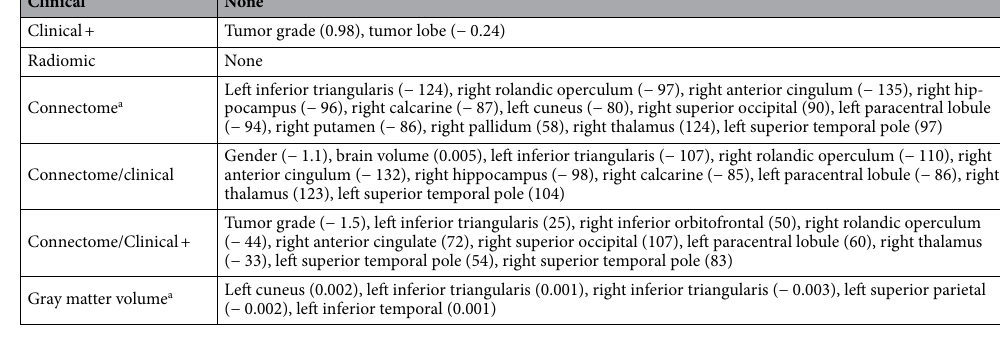
Table 2. Model predictors with a mean p value of 0.05 or less across cross-validation loops. The mean unstandardized coefficient is shown in parenthesis. a See Supplemental Fig. S1 for visualization of predictive